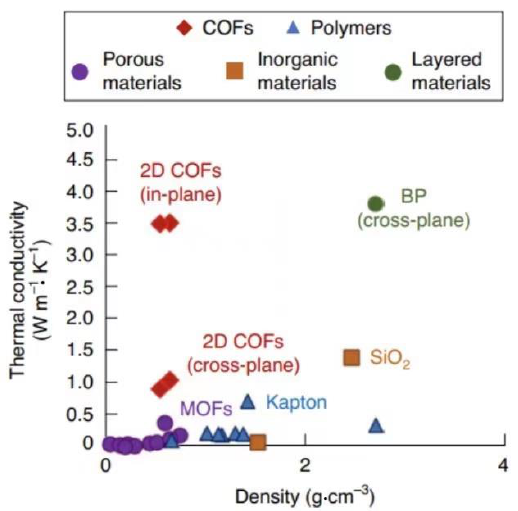
Figure 7. Relationship between the density and thermal conductivity of materials. Adapted with permission [45], Copyright 2021, Nature Materials.